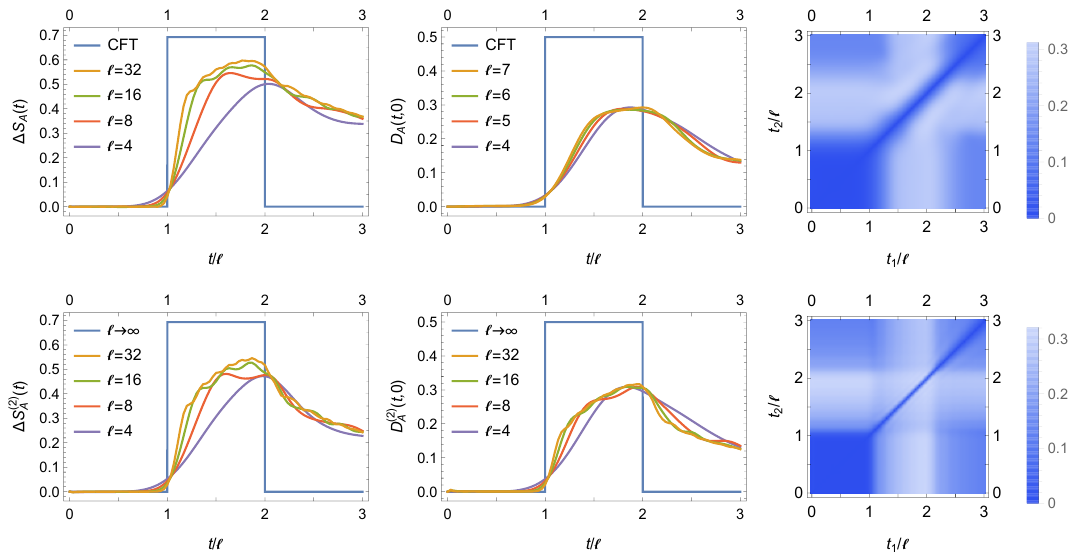
Figure 4 . Time evolution after a local operator quench from a state with the insertion of the operator d (cid:0) 2 ‘ +1 in the critical Ising model. We report entanglement and R(cid:19)enyi entropies, together with trace and Schatten distances for the spin block A = [1 ; ‘ ]. The (cid:12)rst and second rows correspond to order one and two respectively. The plots in the (cid:12)rst column are the time dependence of the entropy increase. The ones in the second column are the distances from the initial state for several (cid:12)xed lengths ‘ . The 3rd column reports colour plots of the distances between two di(cid:11)erent times at (cid:12)xed ‘ ( ‘ = 7 for the trace distance and ‘ = 32 for the Schatten